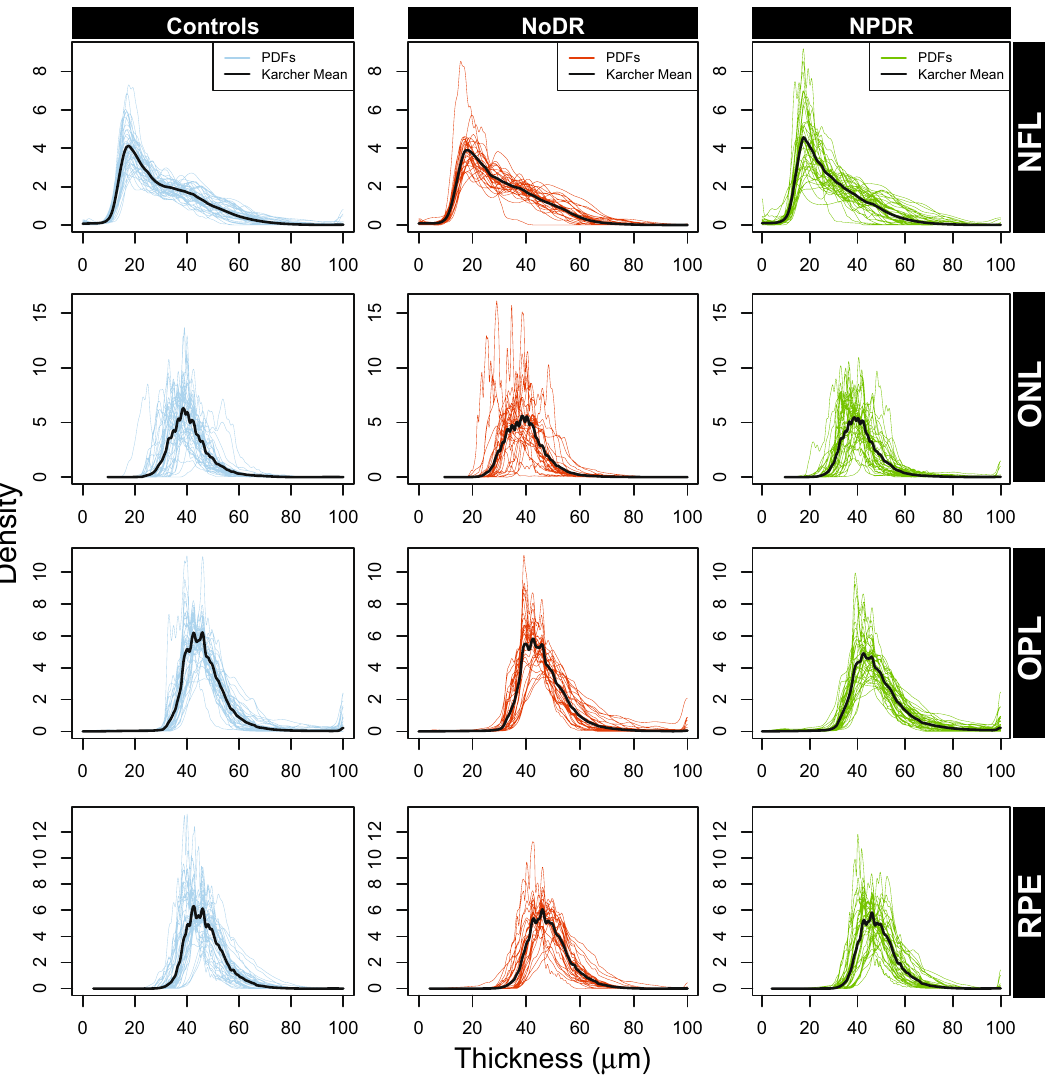
Figure 3. The PDFs of NFL, ONL, OPL and RPE, corresponding to the subjects in each of the three categories: controls, NoDR and NPDR. The solid black line represents the Karcher mean of the PDFs corresponding to the subjects in each controls vs NoDR, the INL had an AUC and a 98.3% CI as 0.673 and (0.504–0.843). To distinguish between controls vs NPDR, the INL and OPL had an AUC and 98.3% CI as 0.793 (0.674–0.912) and 0.743 (0.602–0.884), respectively. The NFL was the best in discriminating between NoDR and NPDR with the AUC and CI as 0.668 (0.508–0.828), whereas the OPL was the next best with an AUC of 0.615. The 98.3% CIs for AUC for all the other layers and pairwise comparisons included 0.5. The results from Tables 2 and 3 indicate that the predictive models using the density-based features outperform the models with summary statistics in terms of the AUC and CI for the layers with reasonable discriminative power (lower bound for CI> 0.5). For the comparison between NoDR vs NPDR, NFL performs best with summary statistics as predictors whereas OPL is most predictive with the density-based features. Note that although their AUCs are the highest (compared to other layers) for NoDR vs NPDR, the lower bounds of the associated CIs are close to 0.5. Hence, these results need to be interpreted with caution unlike other comparisons (e.g. INL in controls vs NPDR), where the indication of performance is stronger both in terms of AUCs and their CIs. Additionally, the evident differences (wiggly peaks) between average PDFs of NoDR and NPDR in OPL (see Fig. 3), are better captured by density-based features compared to summary statistics that fail to capture such nuances in the distribution of pixel intensity values. Similar arguments hold for the comparison between controls vs NPDR in GCL (see Fig. 2). However, the average PDFs of NFL in NoDR and NPDR (see Fig. 3) do not exhibit any evident visual differences. In this case, the PDF-based approach might not be adding additional insight compared to the summary statistics. All other discriminative layers show concordant performance in terms of AUCs with the density-based features performing better for the best predictive layers. Therefore, the ability of our functional data approach to capture